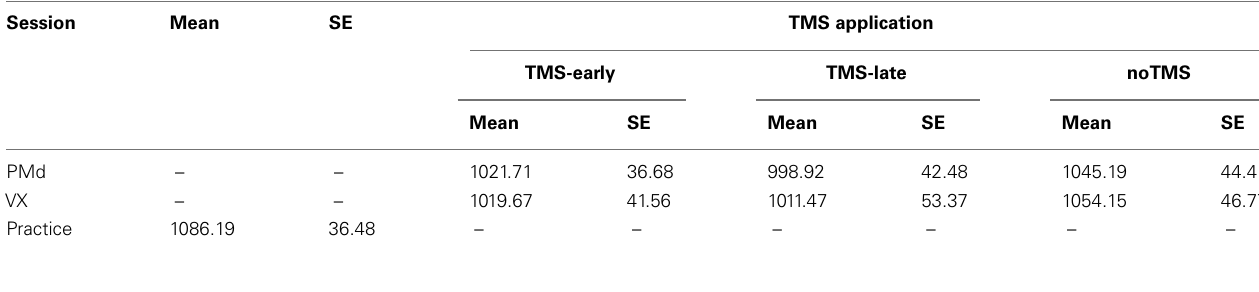
Table 2 | Mean reaction times and SE forTMS (TMS-early,TMS-late) and noTMS trials, for the twoTMS sessions (PMd andVX) and for the practice